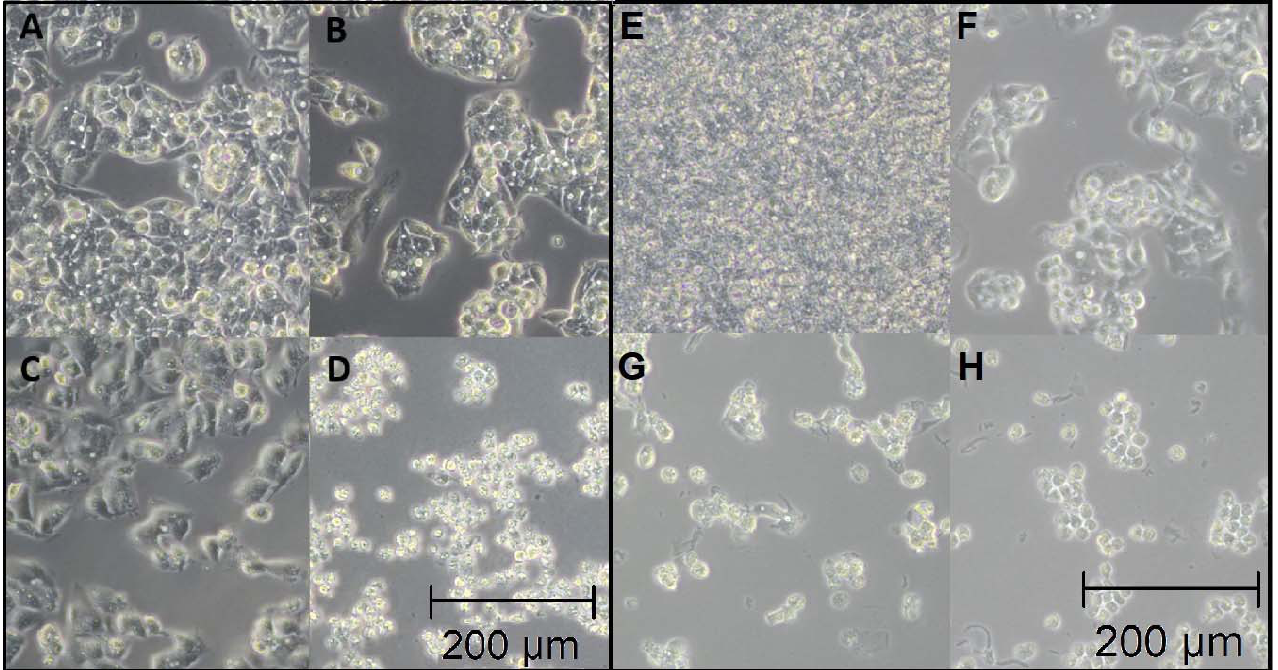
Figure 2. Optical microscopy photographs under the influence of AFB1 on the HepG2 cell line ( A – D ) exposed to different concentrations for the control ( A ), 5 μ M ( B ), 50 μ M ( C ), and 250 μ M ( D ) AFB1 concentrations. A similar investigation was conducted for INH ( E–G ) showing the control ( E ), 5 mM ( F ), 50 mM ( G ), and 250 mM ( H ) INH concentration. For all photographs, magnification was 20×.